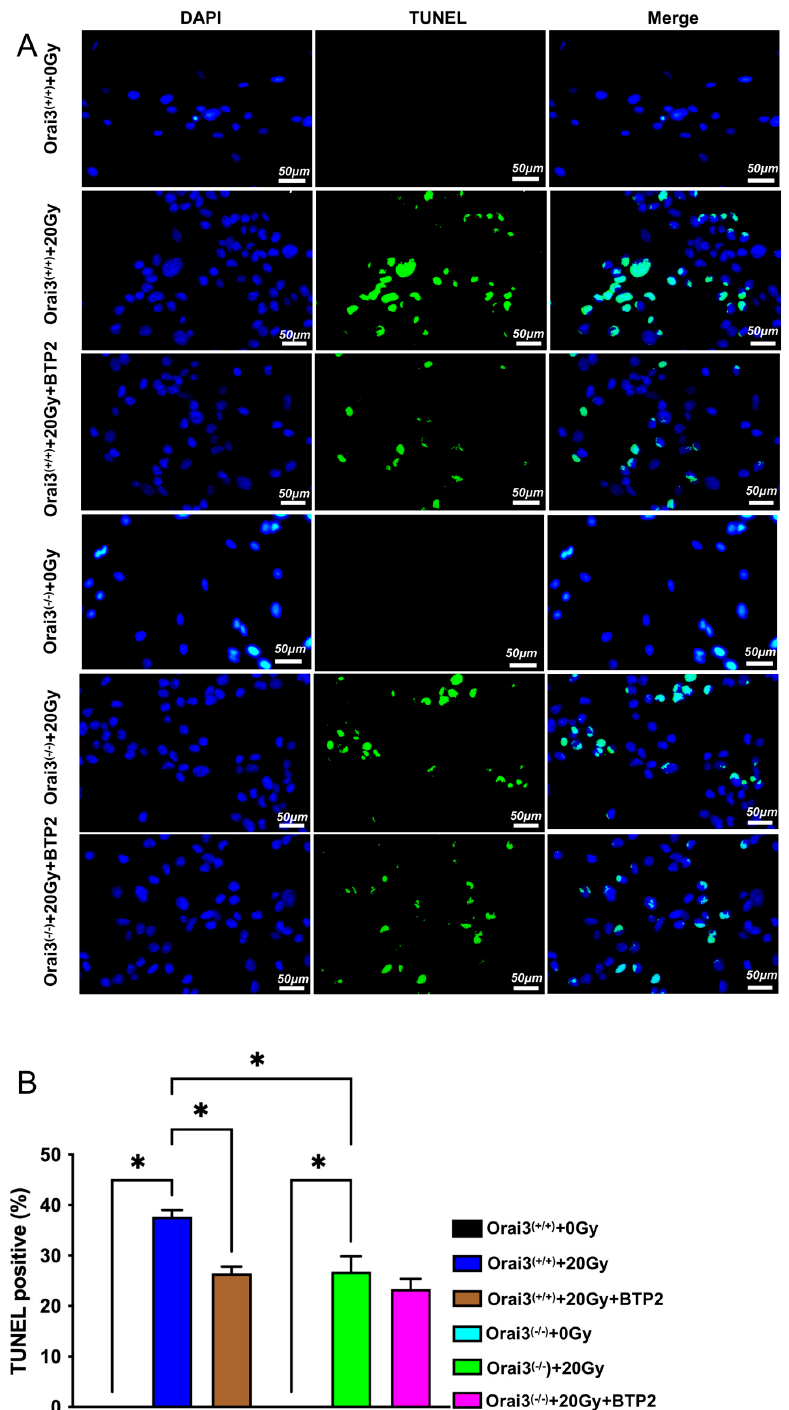
Figure 6. Role of Orai3 in X-ray irradiation-induced apoptosis of rat brain microvascular endothelial cells (rBMECs). ( A , B ) Representative images of TUNEL staining ( A ) and summary data ( B ) showing rBMEC apoptosis 24 h after cells derived from wild-type rats (Orai3 (+/+) ) and unexposed (0 Gy) or exposed to X-ray irradiation (20 Gy) and untreated or treated with BTP2 (5 µ M); and cells derived from Orai3 knockout rats (Orai3 ( − / − ) ) and unexposed (0 Gy) or exposed to X-ray irradiation and untreated or treated with BTP2 (5 µ M). Green represents apoptotic cells stained through the TUNEL assay and blue indicates the cell nucleus stained by 4’,6-diamidino-2-phenylindole. Data are shown as the mean ± SEM ( n = 3), * p < 0.05 analyzed by one-way analysis of variance followed by Dunnett’s multiple comparisons